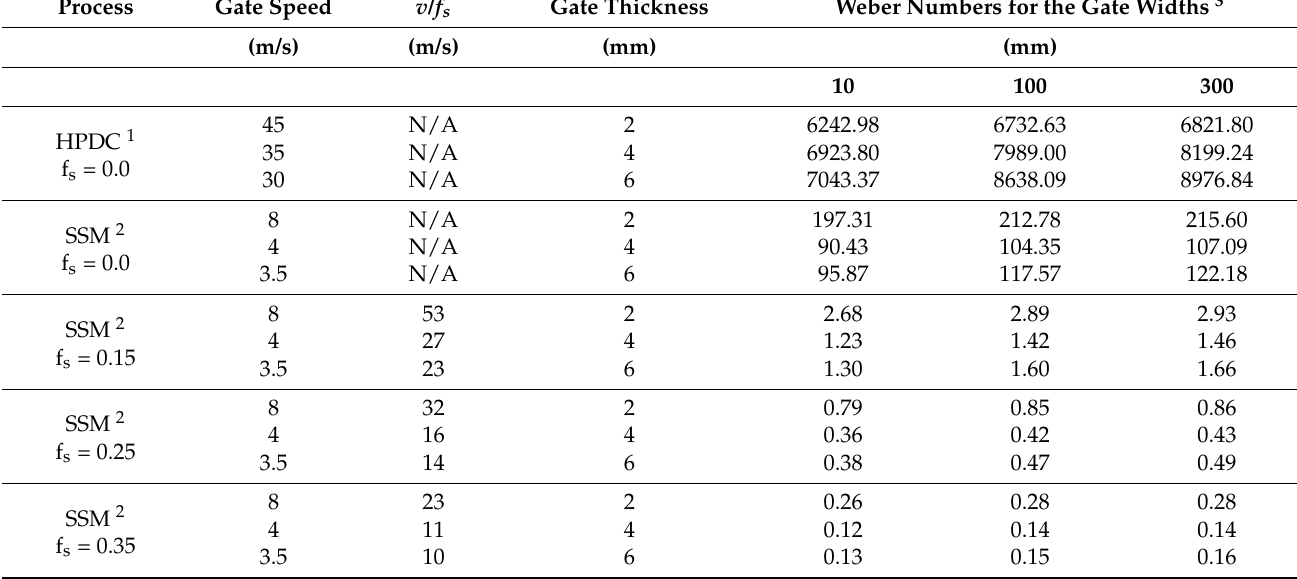
Table 1. Weber number (We) for different processed and